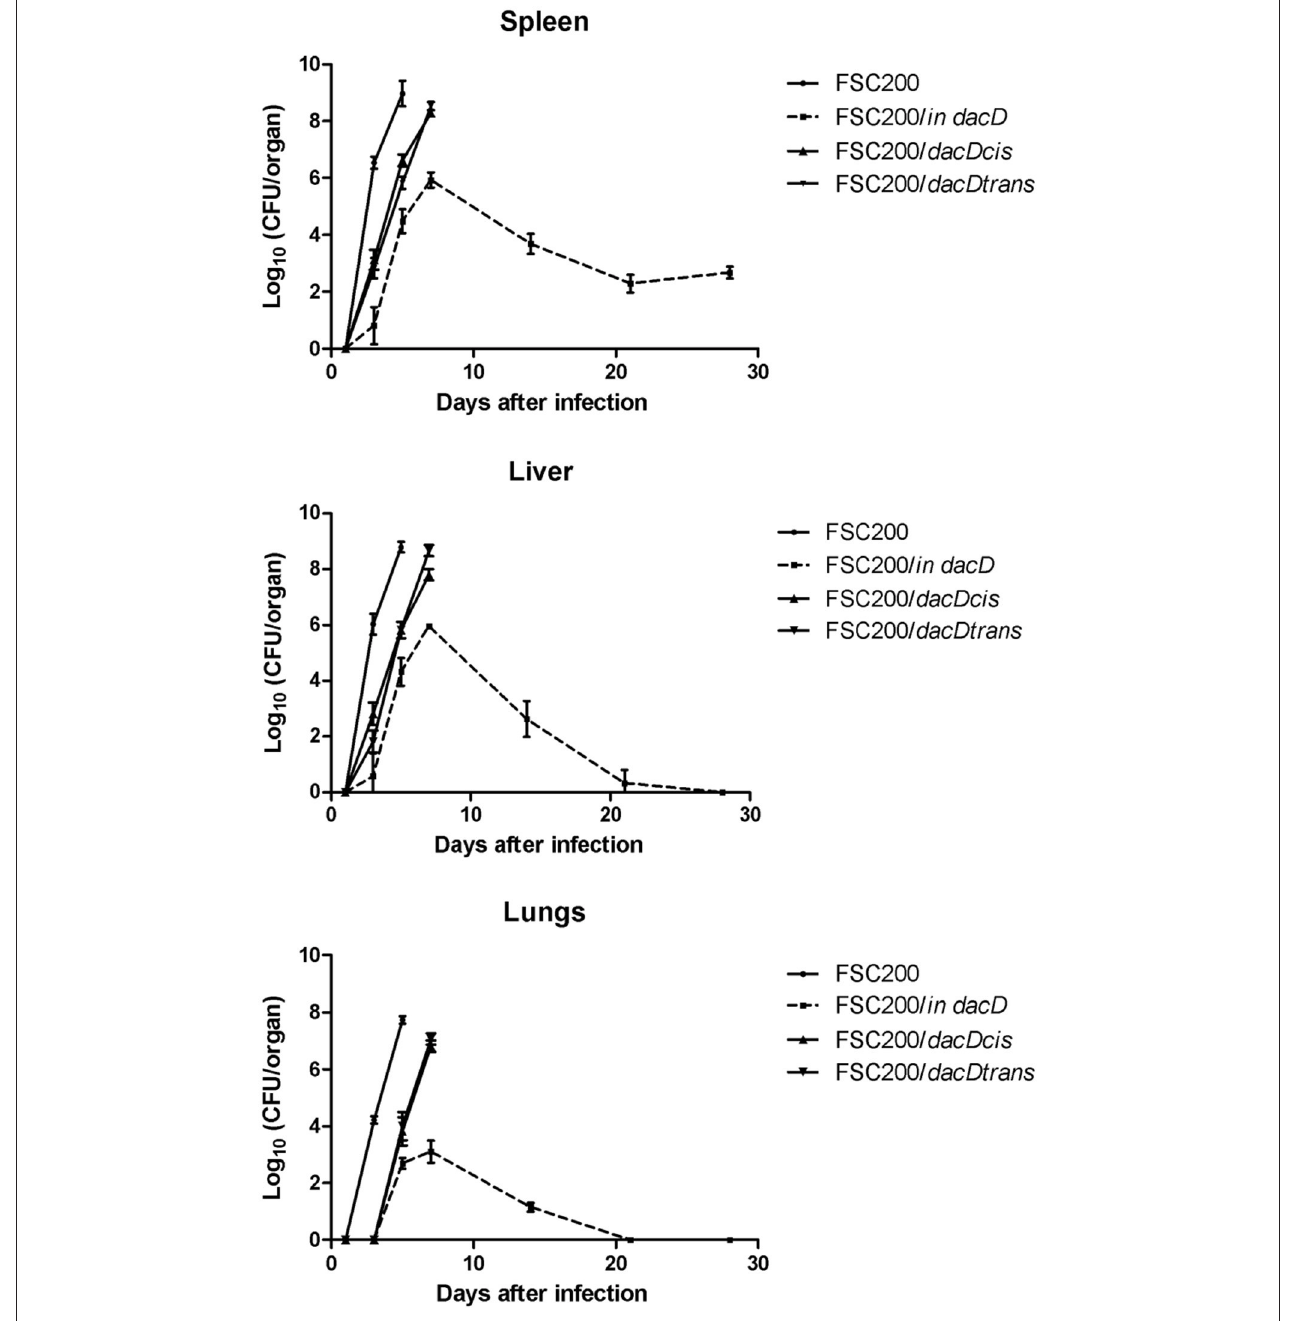
FIGURE 4 | Kinetics of FSC200/ in dacD replication inside target host organs after s.c. infection. The groups of 3 BALB/c mice were infected s.c. with 10 CFU of the wild-type and mutant strains of F. tularensis . At the given time points, the numbers of bacteria in target organs were enumerated by CFU